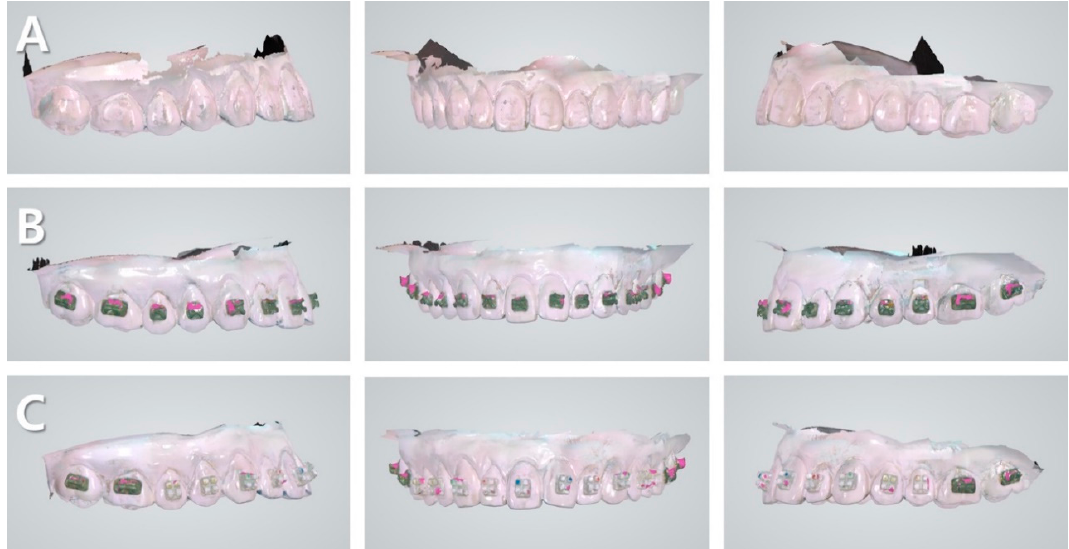
Figure 2. Scan image of the experimental on Trios Pod 2 ® . ( A ) Control group (the model without a bracket), ( B ) MB group (the model with a metal bracket), and ( C ) CB group (the model with a monocrystalline bracket).